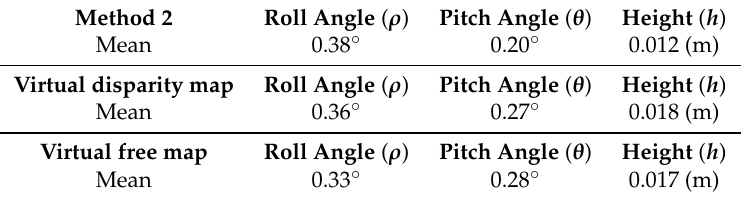
Table 2. Statistics error of the self-calibration of the extrinsic parameters by using Method 2 and the algorithm presented in [11] (virtual disparity